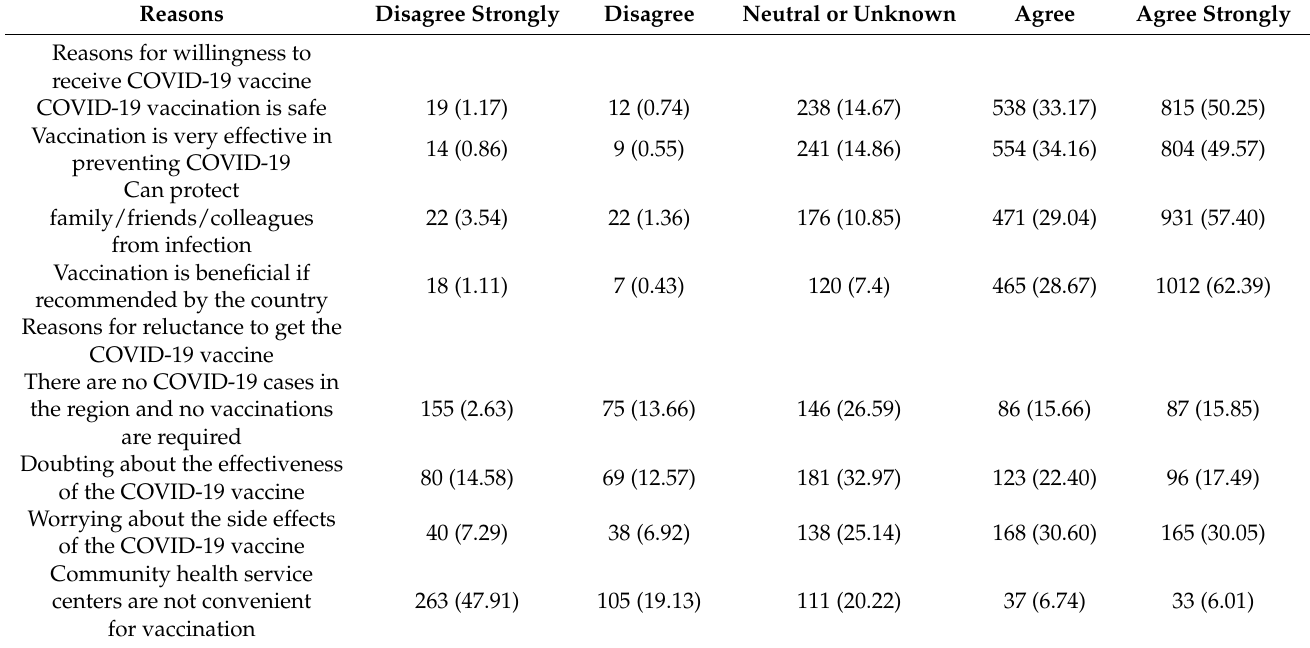
Table 8. Reasons for willingness or unwillingness to receive the COVID-19 vaccine once it is autho- rized under Emergency Use Administration (EUA) n